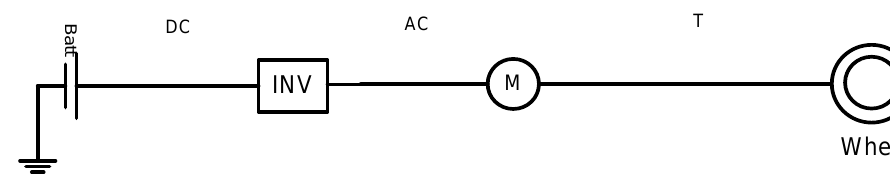
Figure 6. Schematic of a battery electric vehicle (EV) powertrain [24].